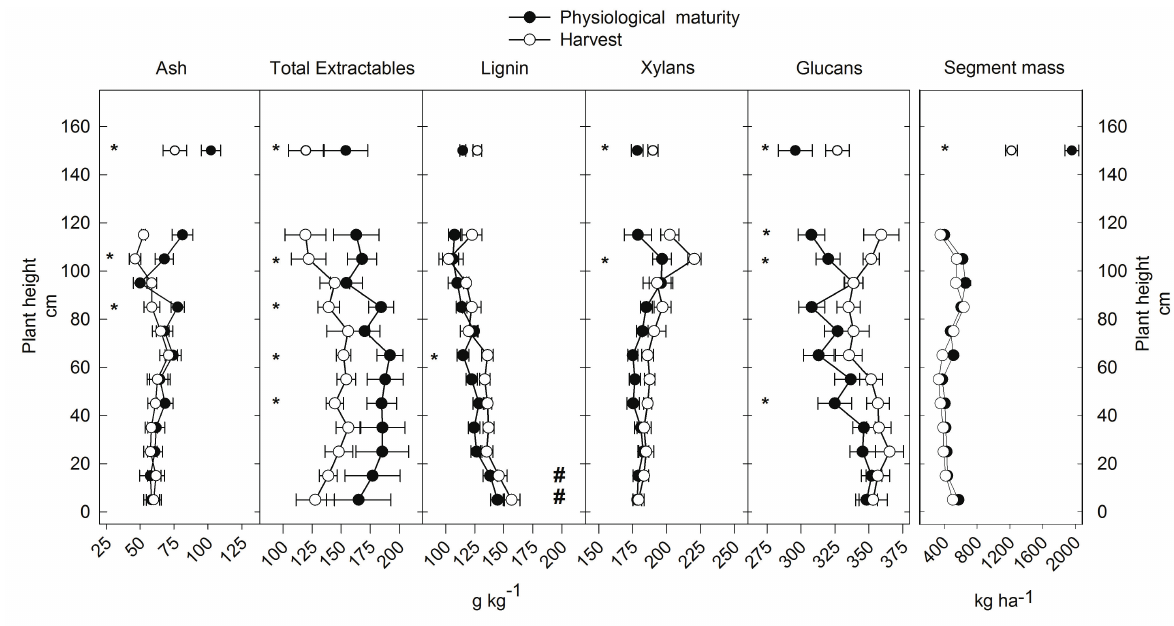
Figure 1. Corn stover composition (g·kg − 1 ) determined by near-infra-red spectroscopy (NIR) and dry mass yield (kg·ha − 1 ) within various 10-cm increments below the primary ear. Constituents in plant material above the ear are arbitrarily plotted at 150 cm rather than reflecting values at that plant height. Means averaged among five locations with the bars indicating one standard error (standard errors bars for segment mass obscured by symbol). The * symbol indicates significant differences between sample dates and the # symbol indicates differences in sample increment. p ≤